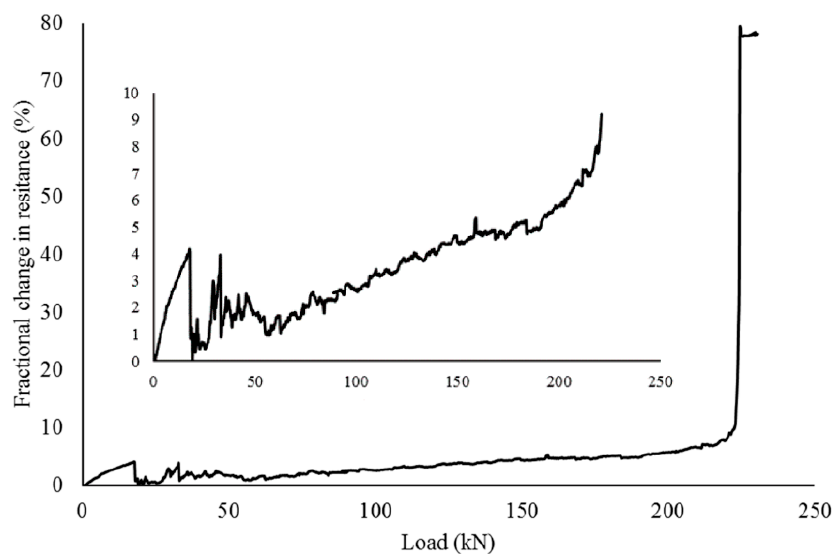
Figure 28. Fractional change in resistance of graphene cement smart sensor specimen subjected to compressive loading on the reinforced concrete beam. Reproduced with permission from [118], MDPI, 2017.